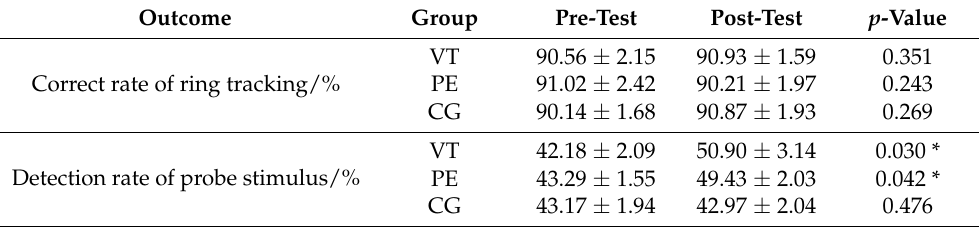
Detection rate of probe